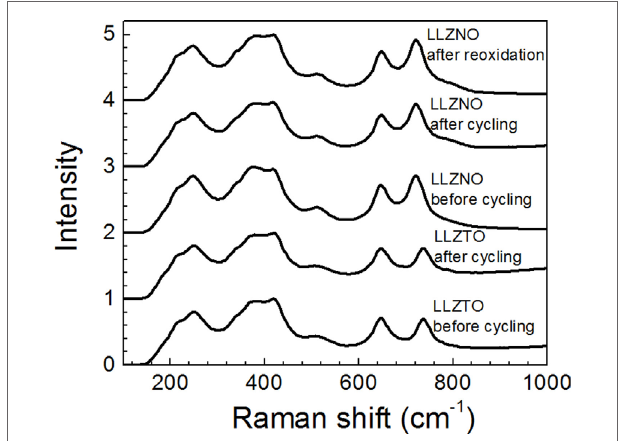
FigUre 6 | X-ray diffraction patterns of hot-pressed li 6.5 la 3 Zr 1.5 Ta 0.5 O 12 and li 6.5 la 3 Zr 1.5 nb 0.5 O 12 after Dc cycling at 23.5 ± 1°c, respectively . ▾ (unknown